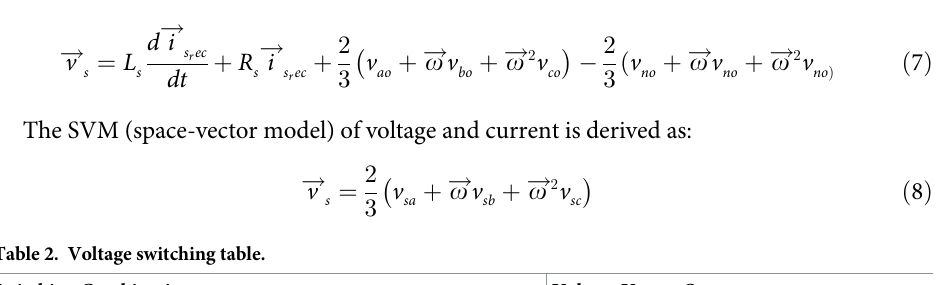
GFE DG DC current control algorithm. The AC/DC converter works as a current source recti- fier (GFE DG) so that power flows from the AC side to the DC side, as shown in Fig 3. After initialization, reference current calculation is performed by measuring input voltage and cur- rent. Then, cost function is calculated for all possible switching states and the switching state